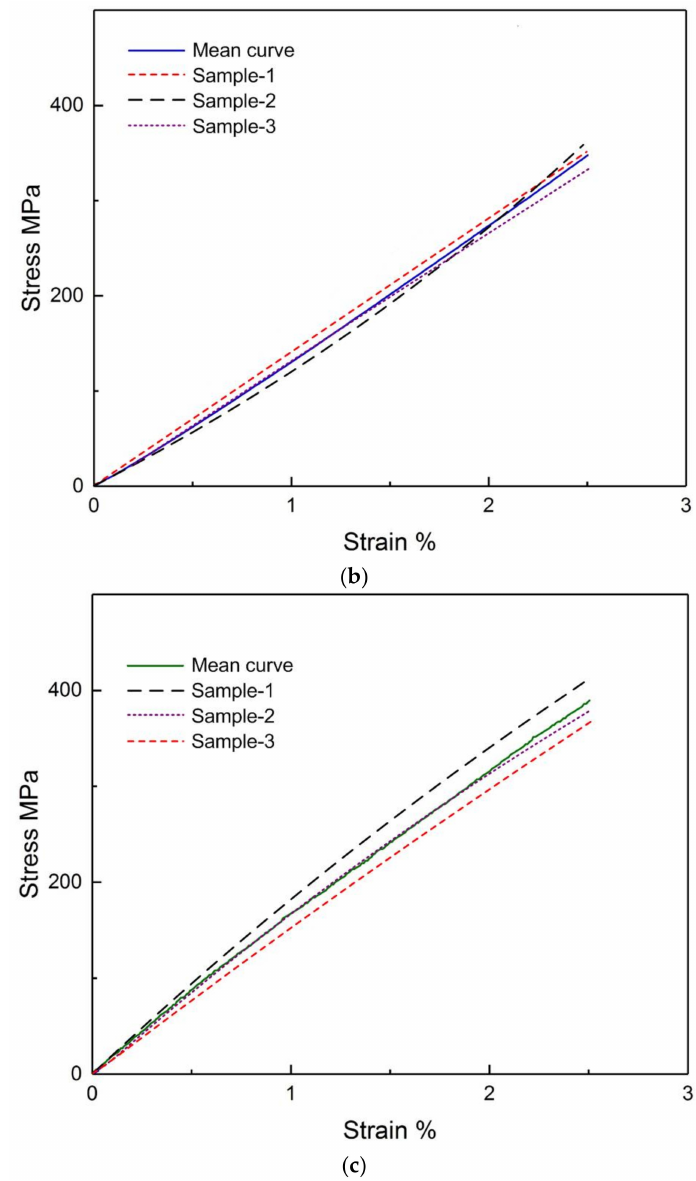
Figure 6. The experimental stress–strain curves for each kind of material: ( a ) SMA wire; ( b ) plain-woven GFRP composite; ( c ) SMA/plain-woven GFRP